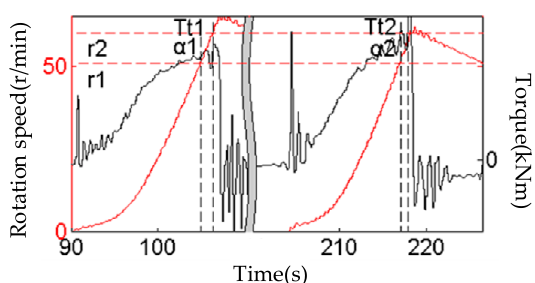
Figure 18. Calibration test results under equivalent inertia of 10497.6 kgm 2 .